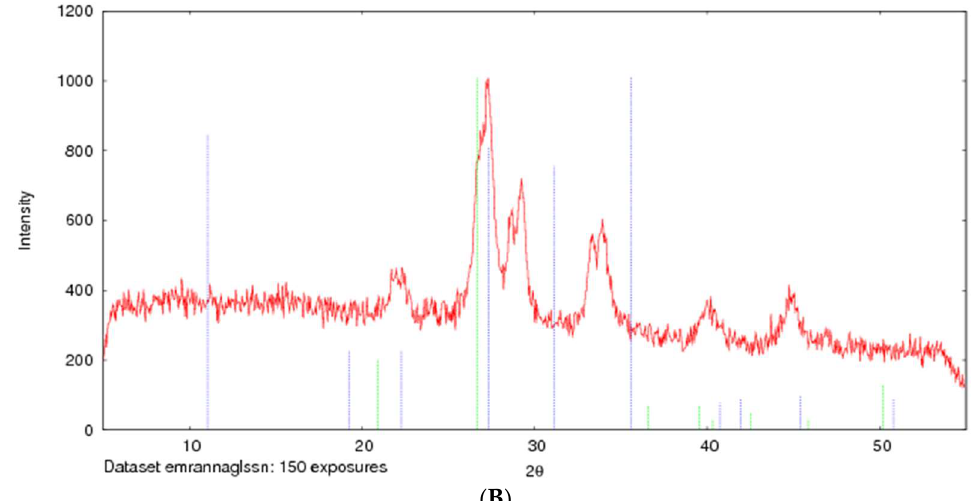
Figure 8. XRD patterns of SSNs (formed with 60 mM of SrCl 2 and 10 mM Na 2 SO 3 , ( A ) and Na-Glc-SSNs (formed with 60 mM of SrCl 2 , 300 mM of NaCl, 200 mM of glucose and 10 mM of Na 2 SO 3 ) ( B ).